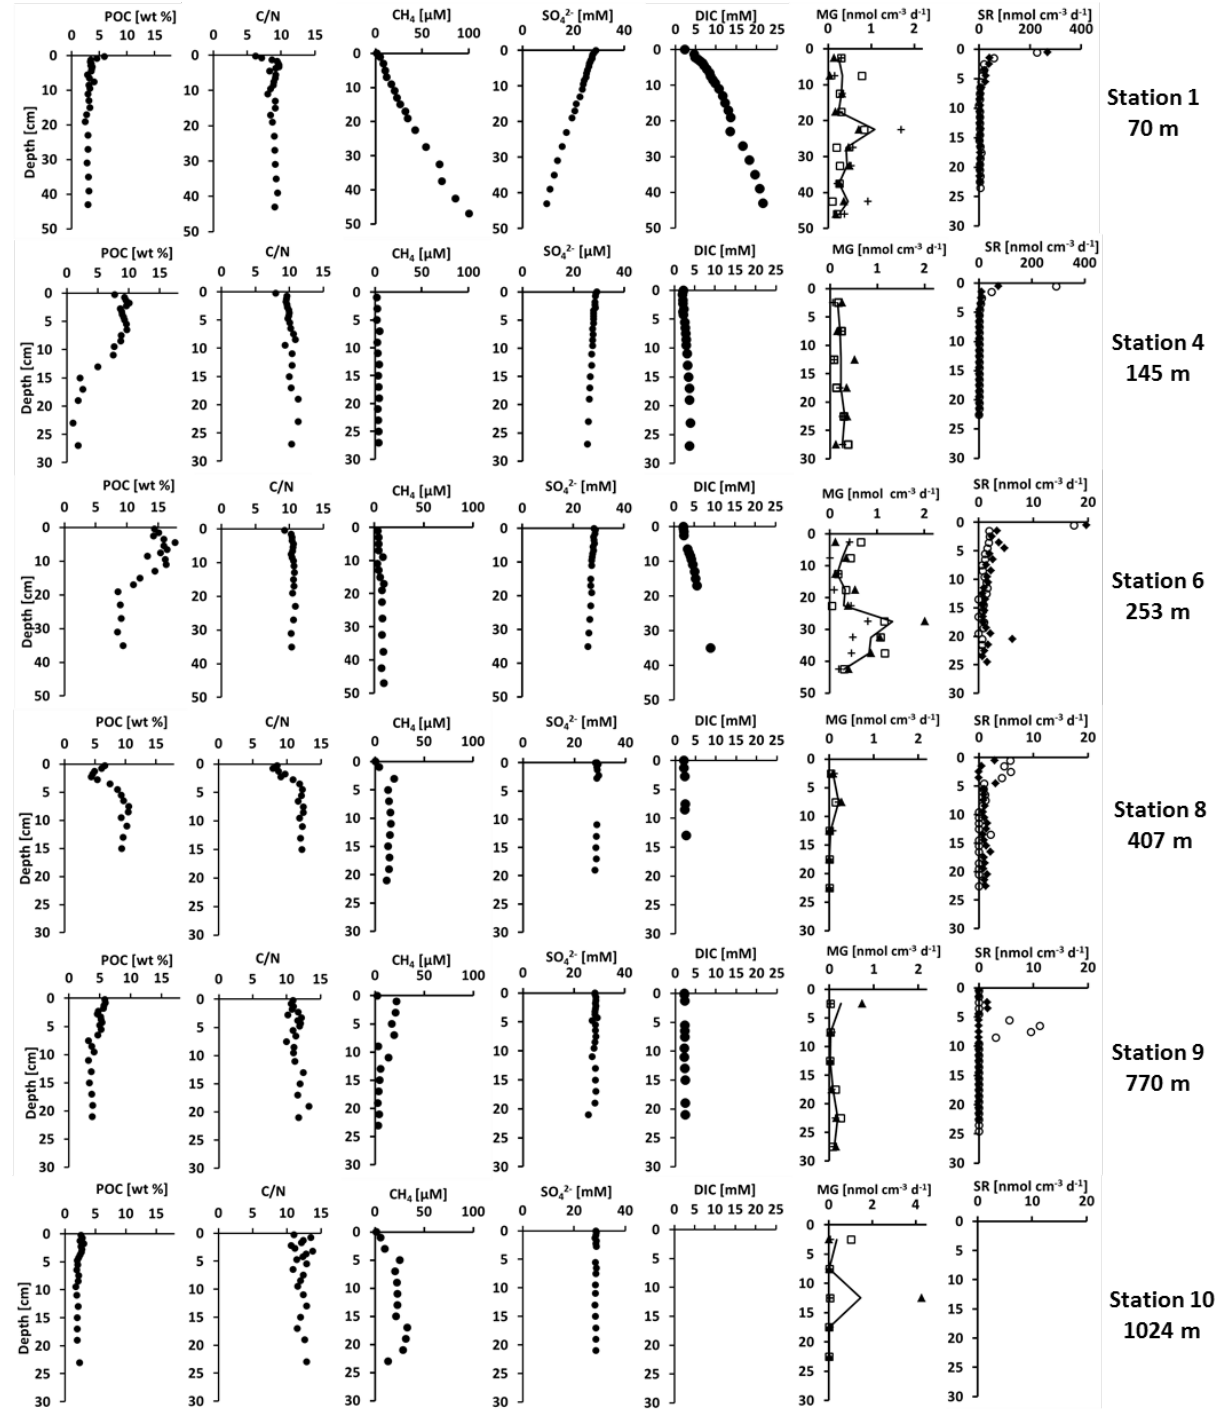
) , DIC (dissolved inorganic carbon), net 4